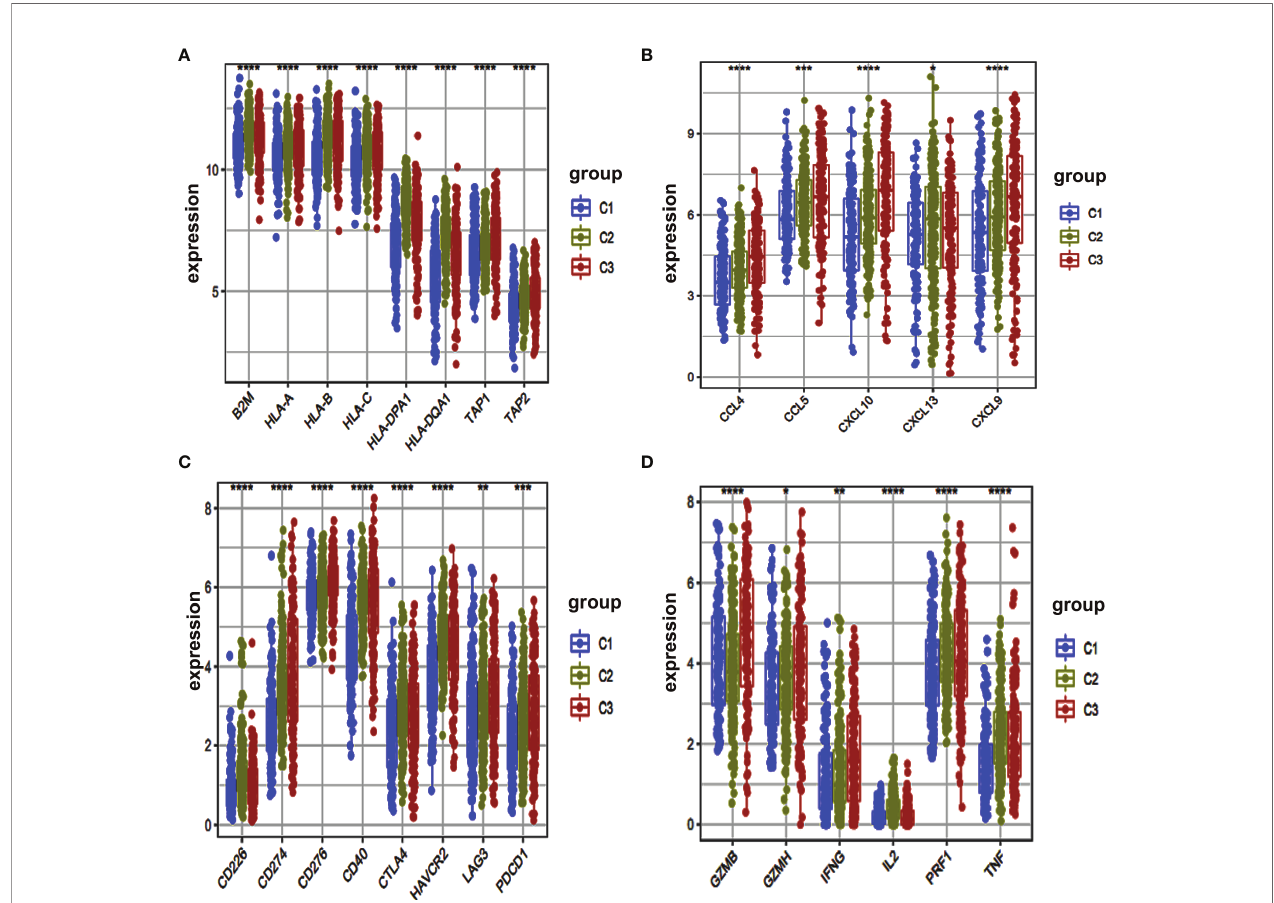
FIGURE 4 | Box plot of immune-related gene expressed among different clusters. (A – D) The expression levels of multiple immune genes were compared in three clusters. *, P < 0.05. **, P < 0.01. ***, P < 0.001. ****, P <